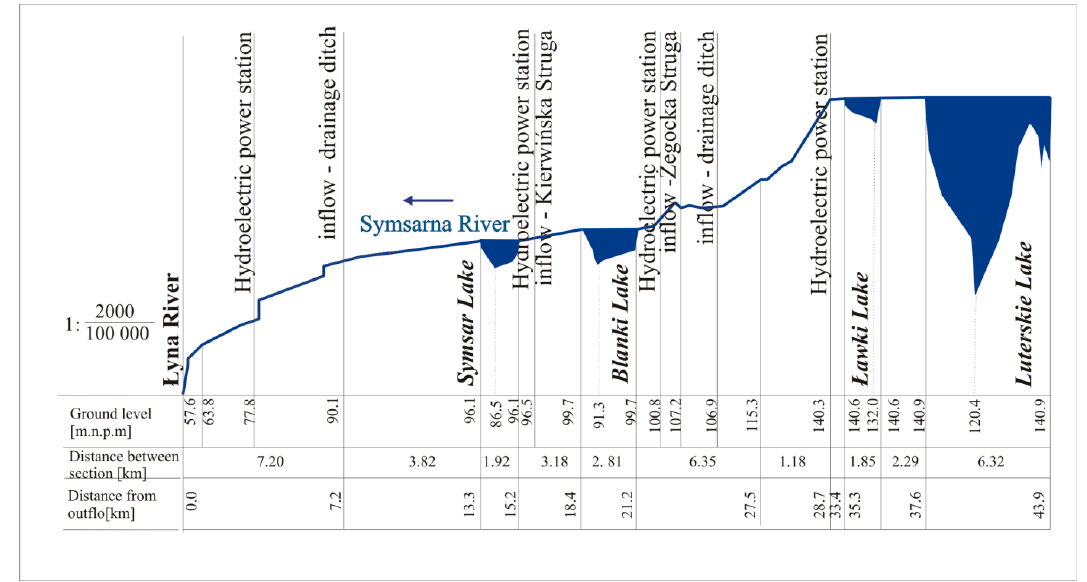
Figure 1. Longitudinal profile of the Symsarna River.